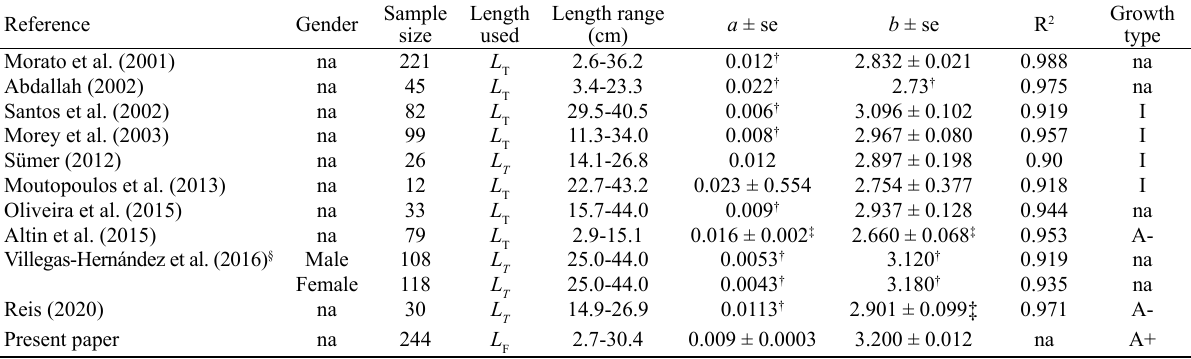
† Standard errors missing from the original publication. ‡ Standard errors estimated here from the 95% confidence interval (CI) provided in the original papers, according to the following equation: s.e.=(upper CI – lower CI) / 3.92. § Body mass was calculated as eviscerate weight instead of total